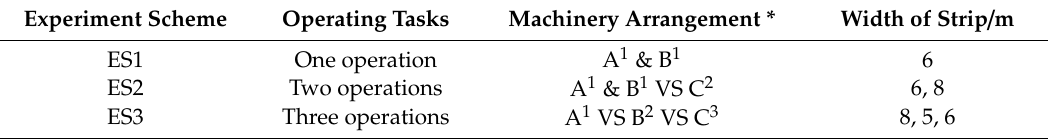
Table 2. Experimental scheme of FMCOS.